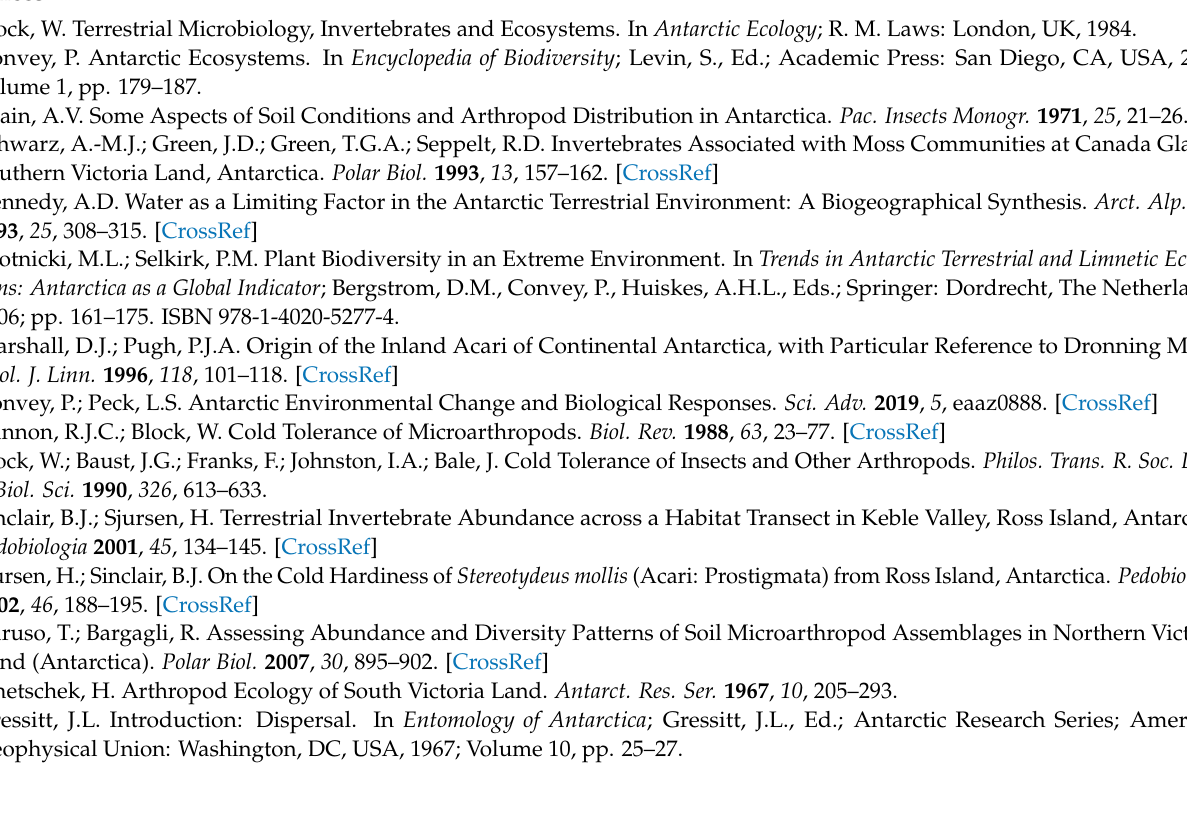
Table S2: Accession numbers of the cox1 sequences of Stereotydeus species and one Eriorhynchidae mite downloaded from GenBank and included in the analyses, Table S3: List of the datasets, number of new sequences obtained and used in each dataset, markers, reference sequences and outgroups used for the analyses and models of nucleotide evolution that best fitted, divided according to the partition applied and to the respective tree search optimization